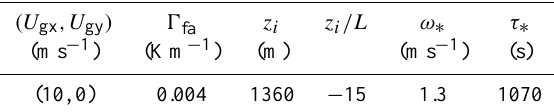
Table 1. Simulation parameters. The symbols indicate: U g the im- posed geostrophic wind, 0 fa the free atmosphere lapse rate, z i the boundary layer height, z i /L , with L the Monin–Obukhov length, the stability parameter, ω ∗ the convective velocity and τ ∗ = z i /ω ∗ the convective timescale. Variables z i , z i /L , ω ∗ and τ ∗ are temporal averages from 10:30 to 12:00UTC, before subsidence is introduced in the simulation.